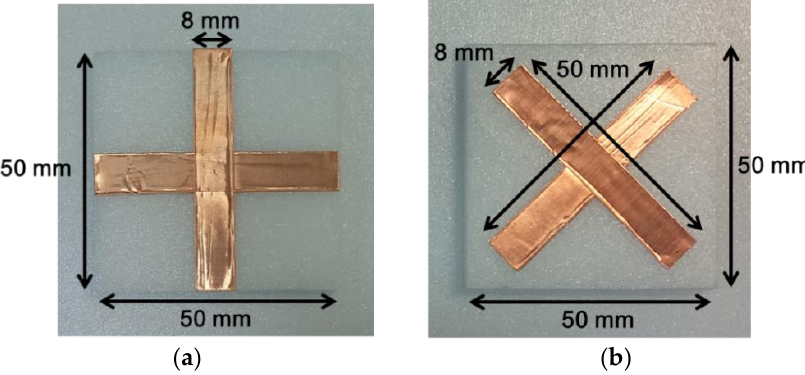
Figure 10. Photographs of two samples for the demonstration of the real-time THz imaging system. ( a ) the pattern of “+” ; and ( b ) the pattern of “−“.